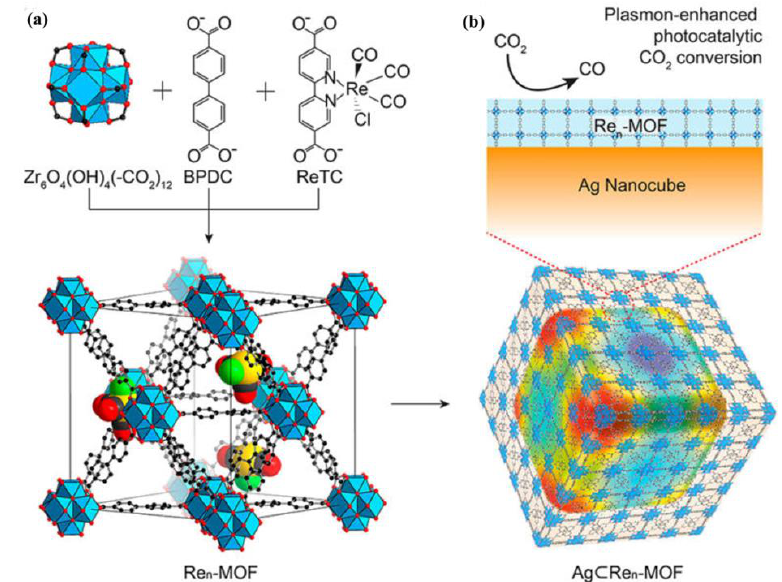
Figure 8. Structures of Re n -MOF and Ag ⊂ Re n -MOF for plasmon-enhanced photocatalytic CO 2 conversion. ( a ) Zr 6 O 4 (OH) 4 (−CO 2 ) 12 secondary building units are combined with BPDC and